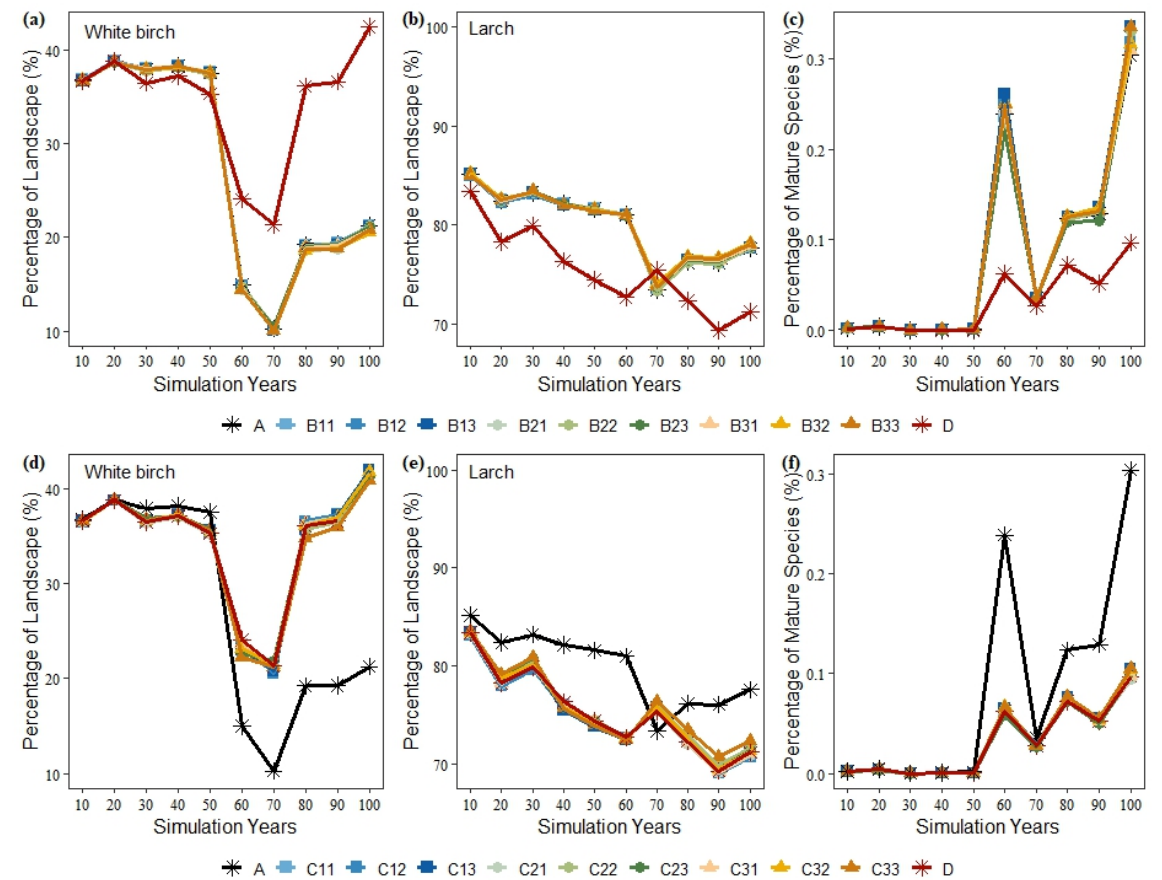
Figure 5. Percentage of landscape and percentage of mature age species for all scenarios. Scenario A and scenario D are the baseline scenarios for comparison, and they do not treat for fuels. ( a – c ) are the PLAND for white birch, the PLAND for larch, and MAS under the nine fuel treatment plans included in scenario B, respectively. ( d – f ) are the PLAND for white birch, the PLAND for larch, and MAS under the nine fuel treatment plans included in scenario